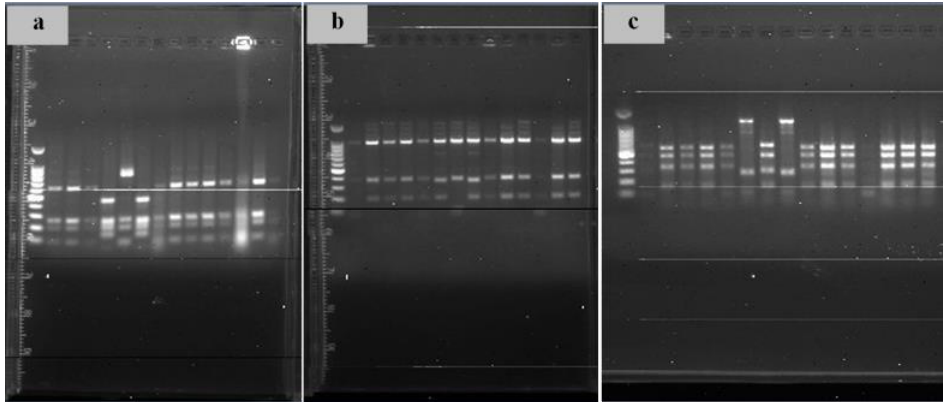
Figure 2. Restriction analysis examples of 16S rRNA genes using the AluI ( a ), HaeIII ( b ), and HinfI ( c ) enzymes.